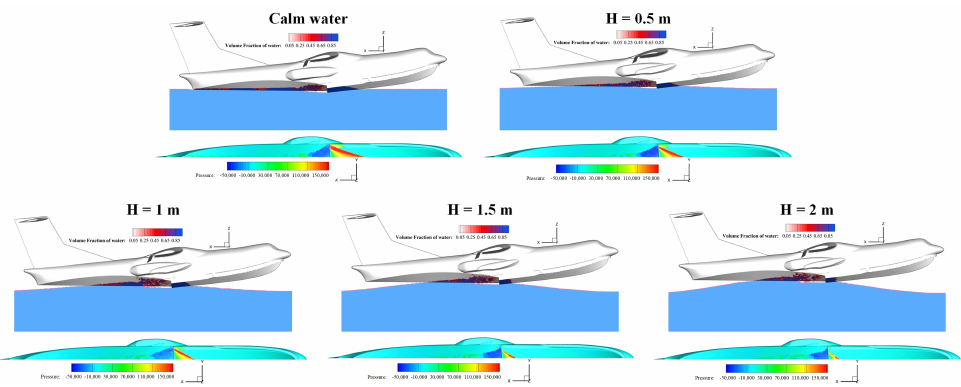
Figure 15. Comparison of free surface and pressure distribution of aircraft landing with different wave heights at t = 0.16 s.